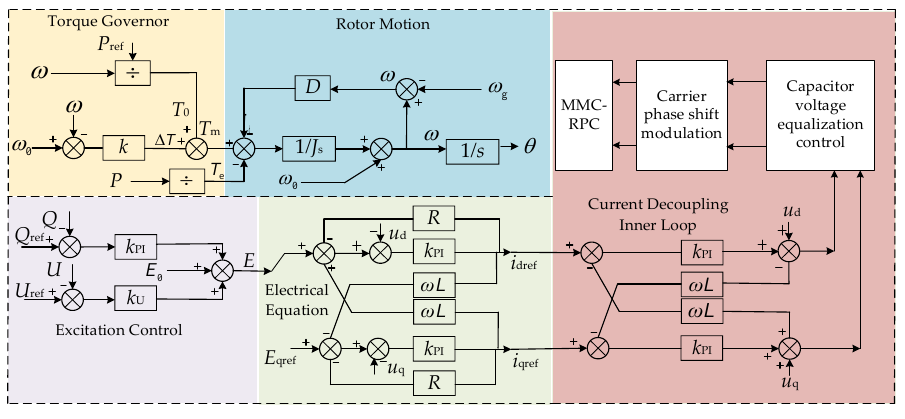
Figure 5. Control chart of MMC-RPC.